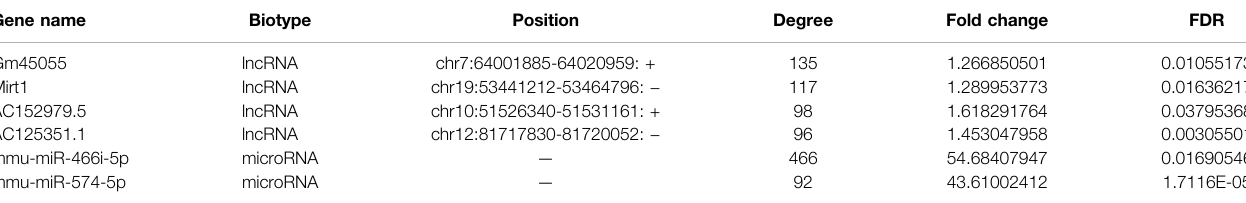
TABLE 1 | The detailed information of top genes ranked by degree after analysis of LncRNA/microRNA -mRNA co-expression correlation network